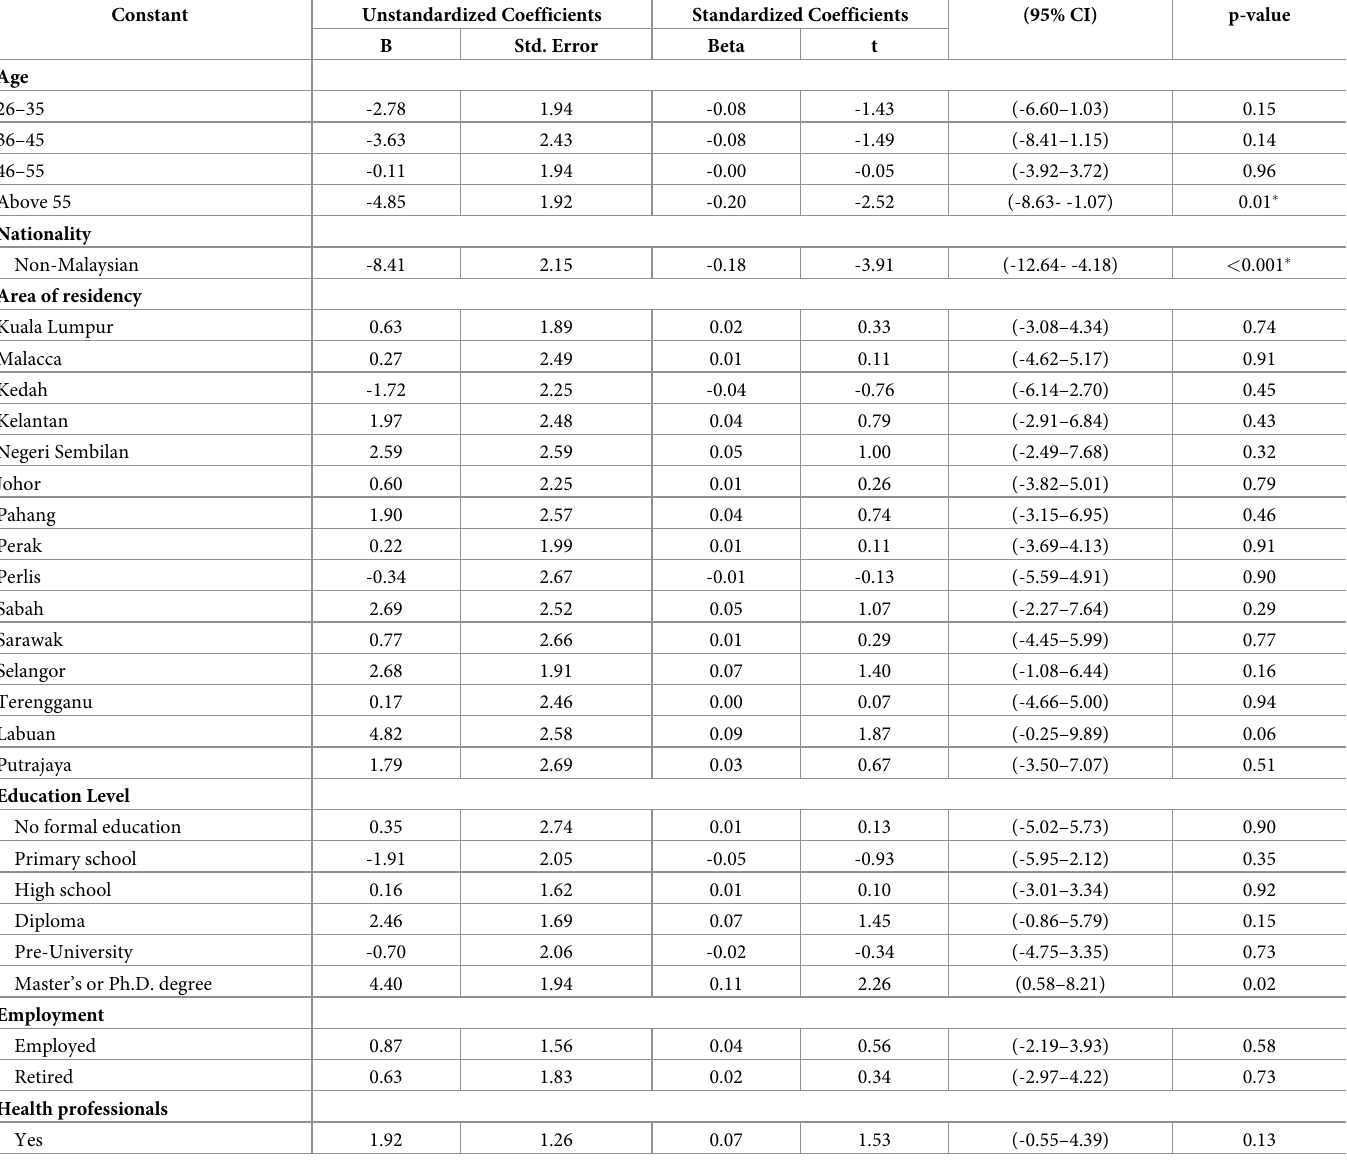
Table 7. Factors associated with perceptions towards drive-thru community pharmacy services among the general population using Multiple linear regression anal- ysis (N = 565).